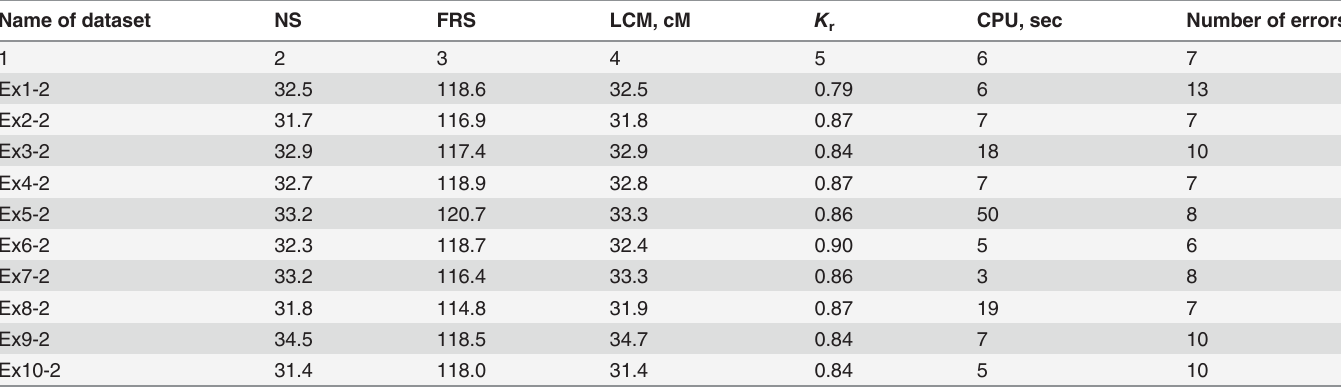
Table 2. Testing the algorithm on datasets of Group 2. Name of